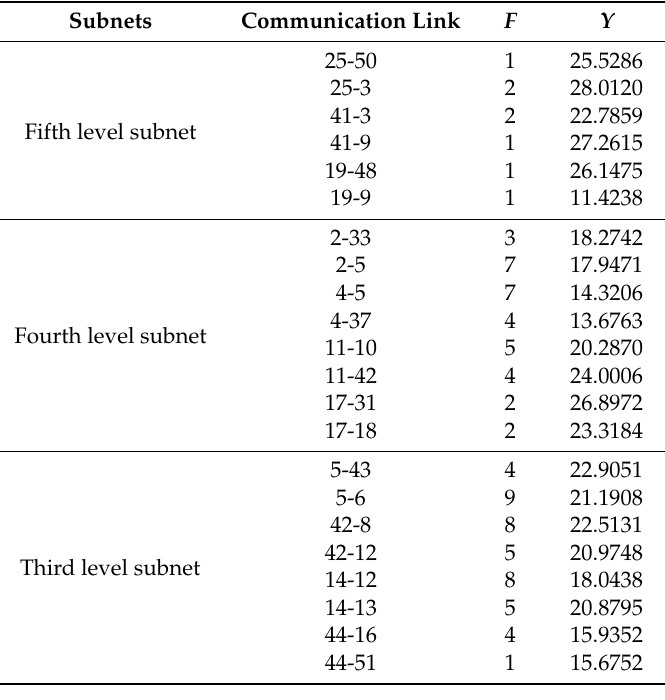
Table 2. Dynamic relay link optimization